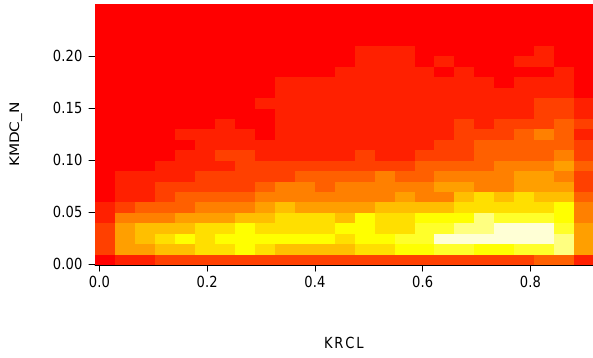
Fig. 2. (A) Heat-map of 2-dimensional marginal distribution of EF- FAC and DRF (decomposition rate factor), the brighter the poly- gons, the higher the posterior value. (B) histogram of DRF using all values and histogram of DRF using only values of DRF, where EFFAC < 0 . 5.